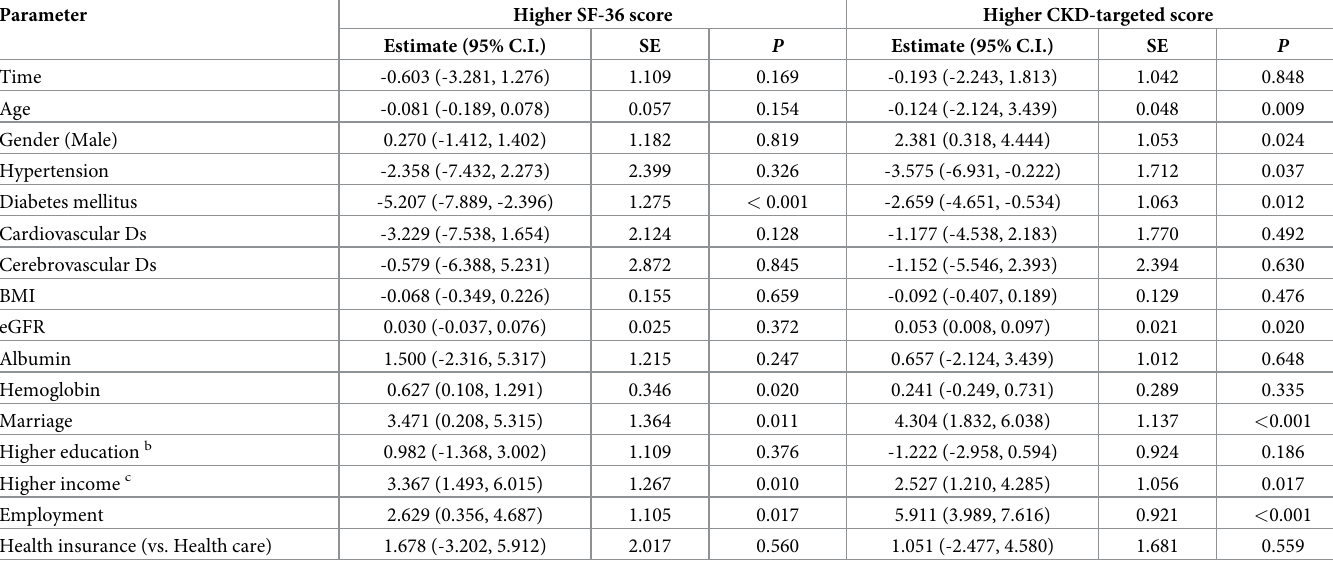
Table 2. Prognostic factors associated with HRQOL in KT patients a .